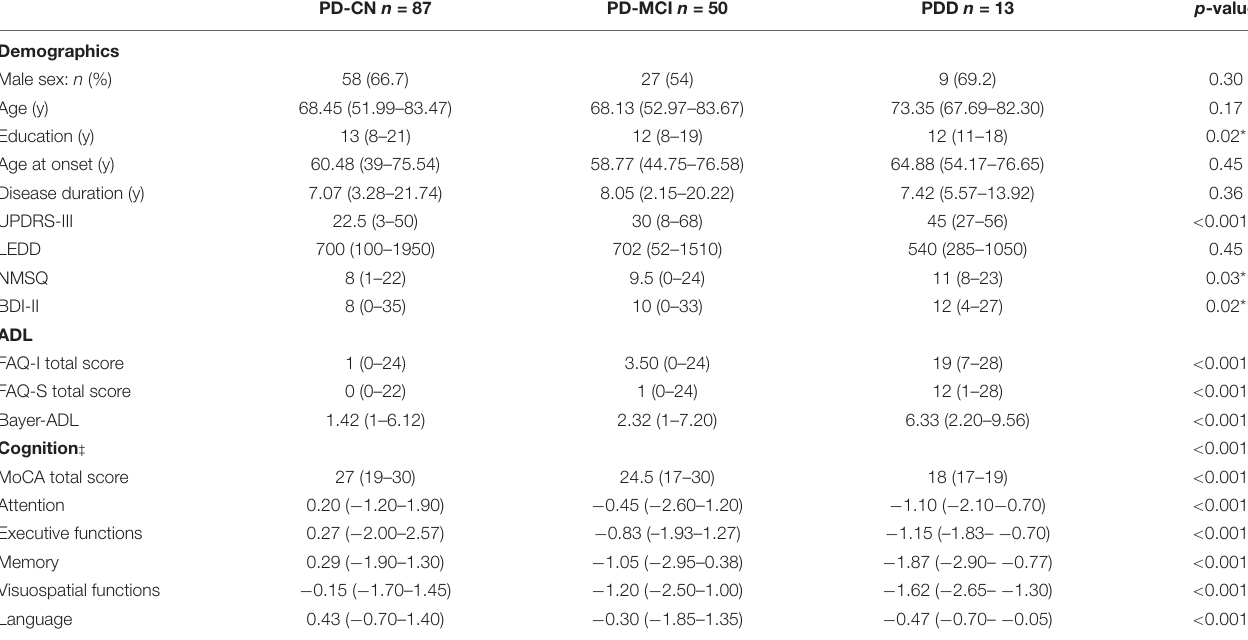
TABLE 1 | Patient characteristics according to cognitive